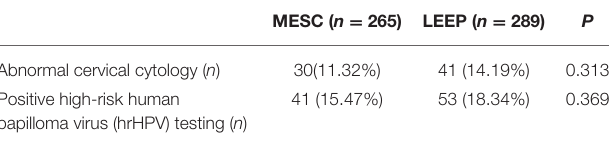
TABLE 3 | The cytology and the HPV test at a 6-month follow-up visit after LEEP or